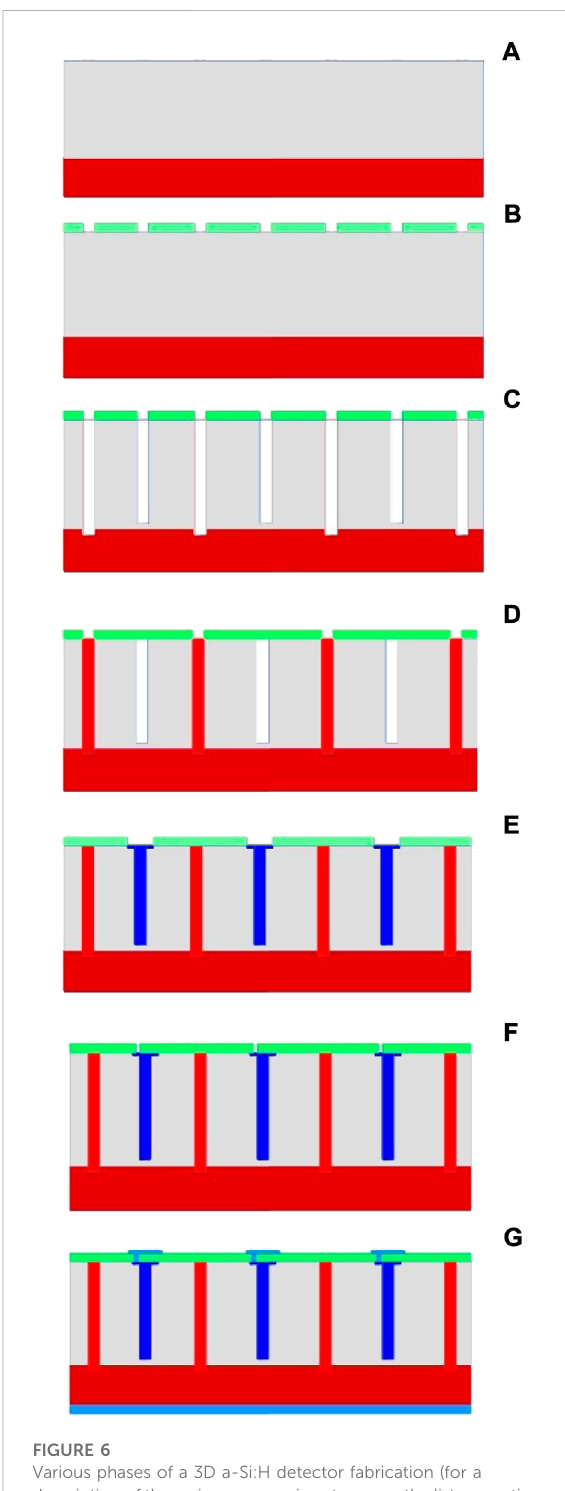
FIGURE 6 Various phases of a 3D a-Si:H detector fabrication (for a description of the various processing steps, see the list on section: 3D a-Si:H particle detectors).